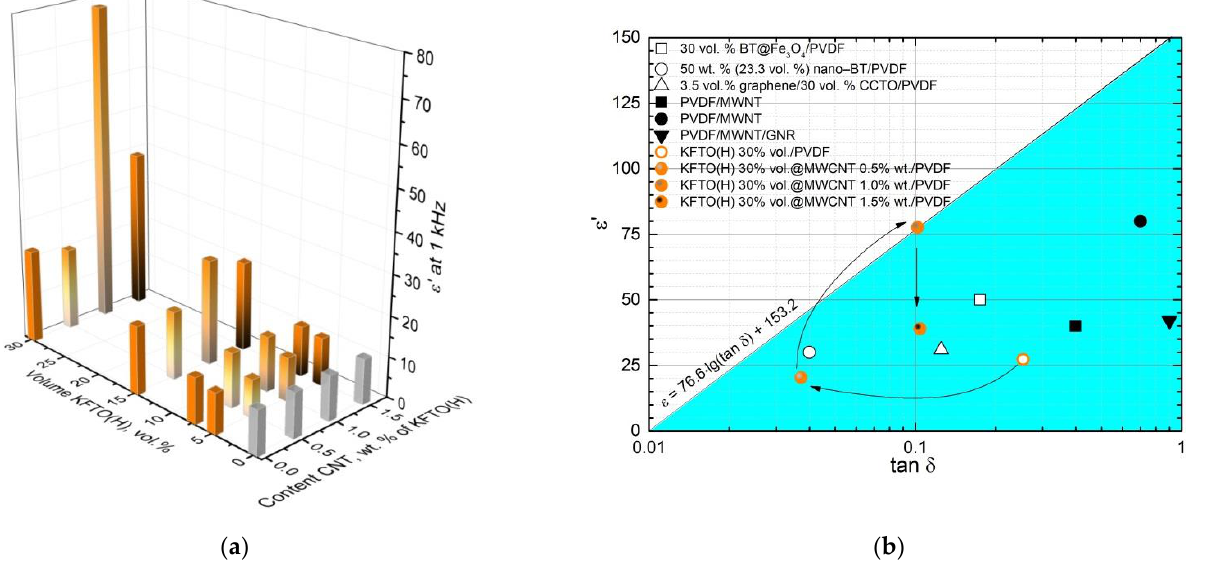
Figure 11. Volume of KFTO(H) and MWCNT content dependence of composite permittivity (gray columns - unfilled PVDF, orange columns without gradient - PVDF filled with KFTO(H), orange columns with gradient - PVDF filled with KFTO(H) and MWCNT.) ( a ) and ε′ and tanδ values of each sample collected from 1 kHz (the blue background is an area of low balance for ε′ and tanδ) ( b ) [37 – 42].